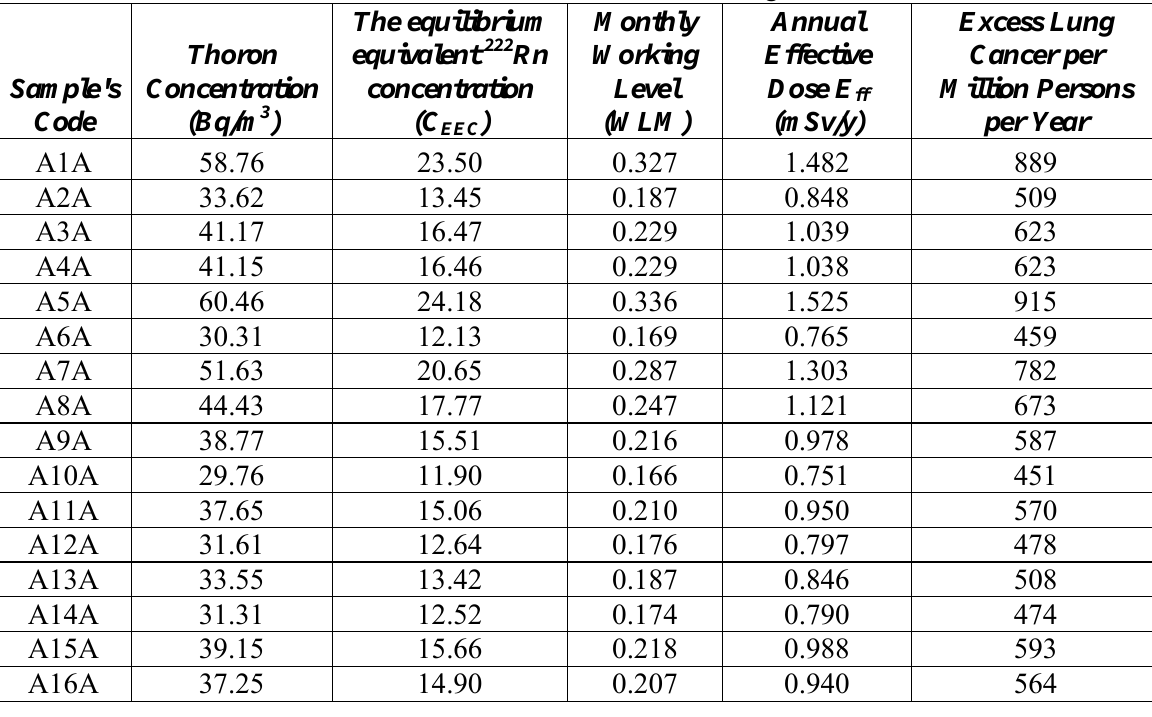
Table 4: The overall results of thoron